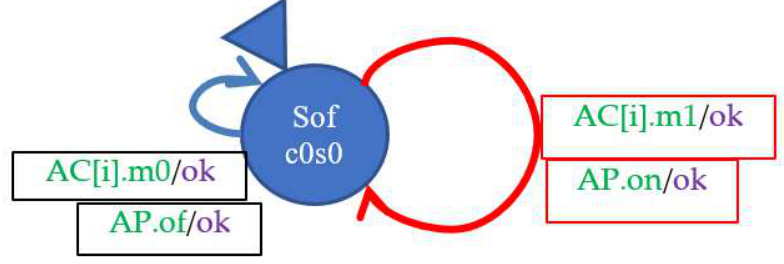
Figure 15. Damaged element—permanent opening of the input with the contact output.